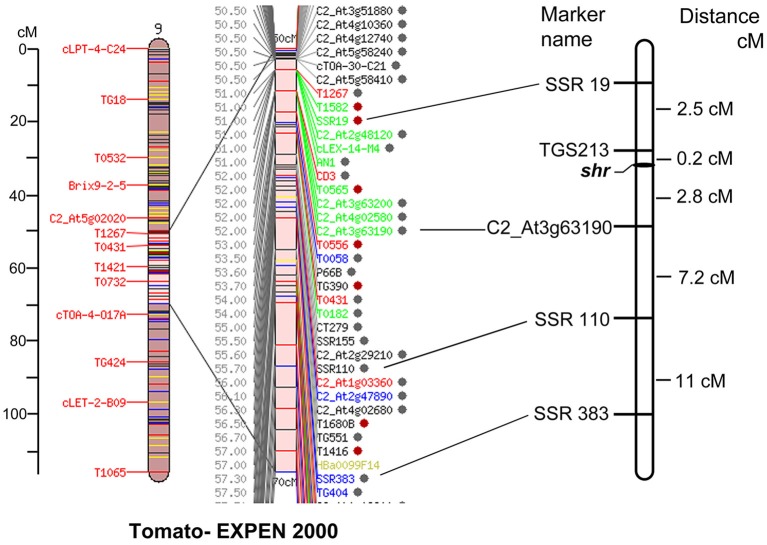
Genetic map of shr locus on chromosome 9 using shr x S. pimpinellifolium F2 mapping population (n = 769) (right). The Tomato-EXPEN 2000 map (left) shows positions of markers on the map. shr locus was identified within TGS0213 and C2_At3g63190 markers. The distances for the maker position are given in centi-Morgan (cM).